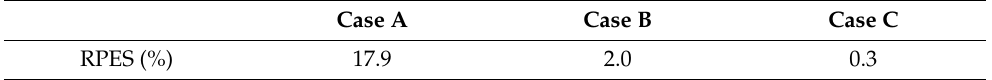
Table 5. Annual average relative primary energy savings for the cases